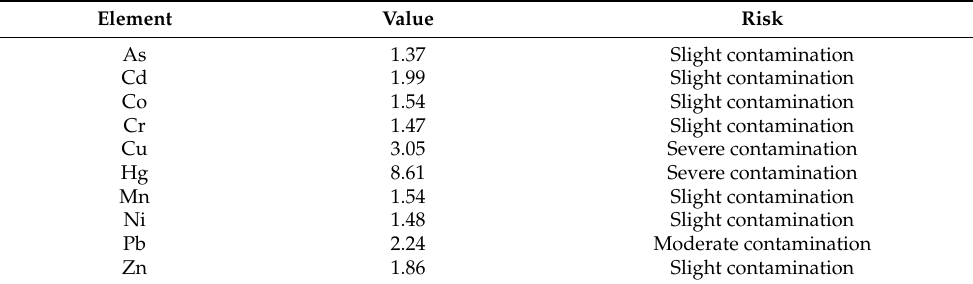
Table 5. Nemerow composite index.